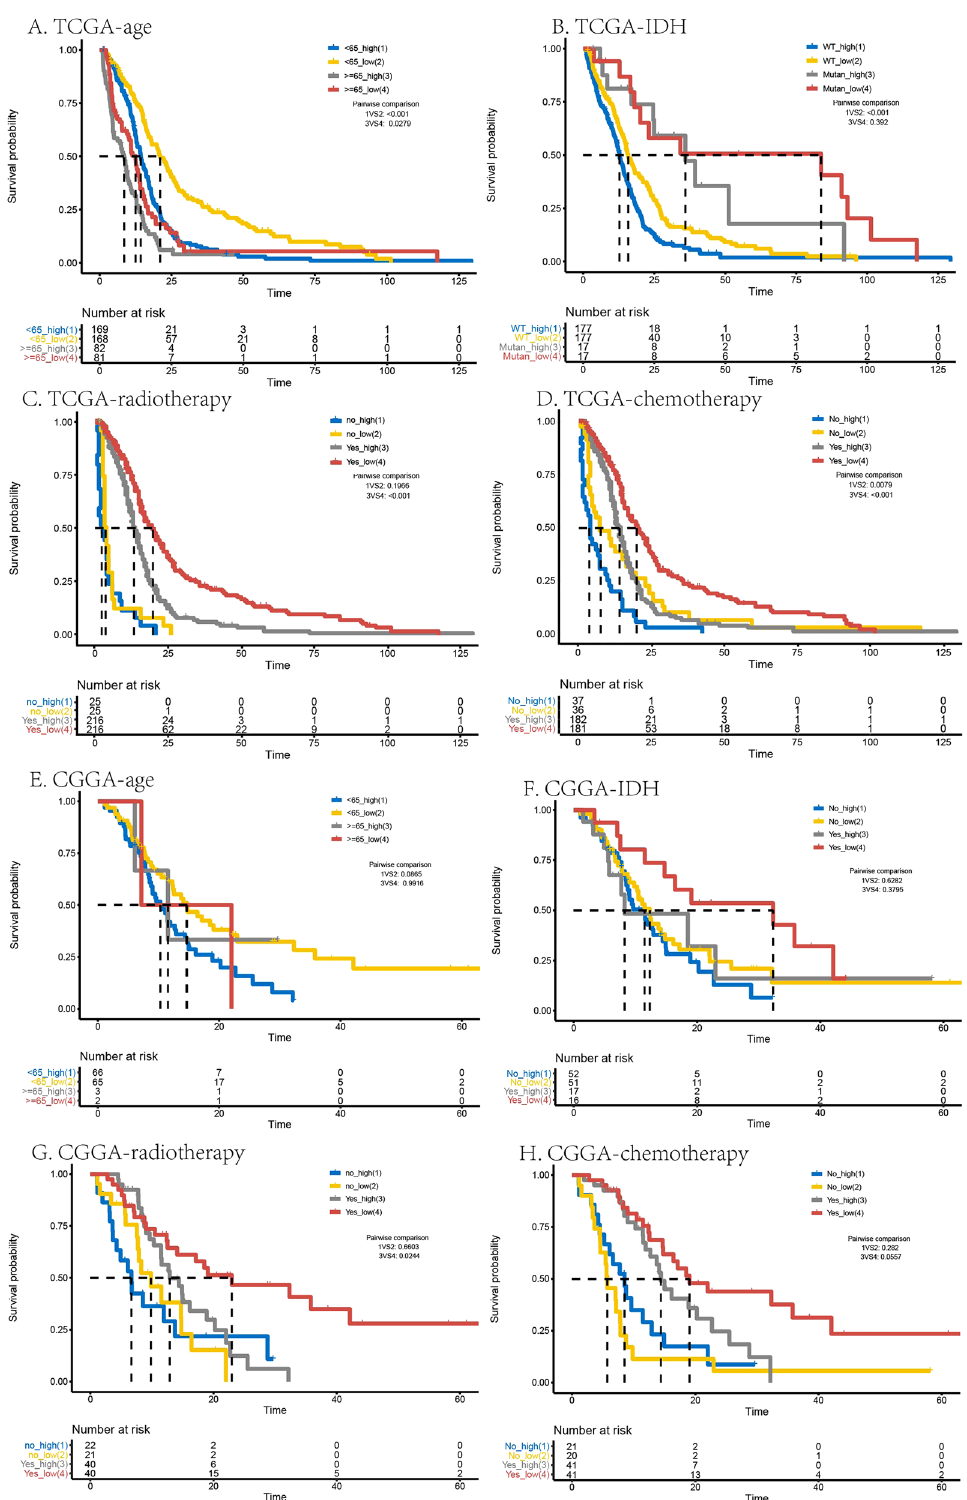
Figure 4. OS survival probability evaluated in GBM through age, IDH, radiotherapy, and chemotherapy in TCGA ( A – D ) and CGGA ( E–H ). The p values were shown in the plot